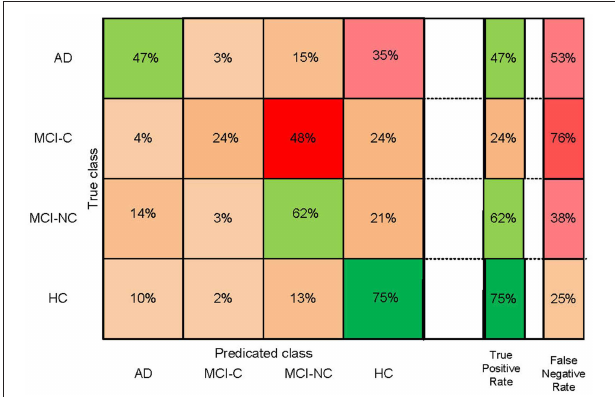
FIGURE 2 | Confusion matrix of four-group (AD, HC, MCI-C, and MCI-NC) classification based on the SFC feature selection algorithm.